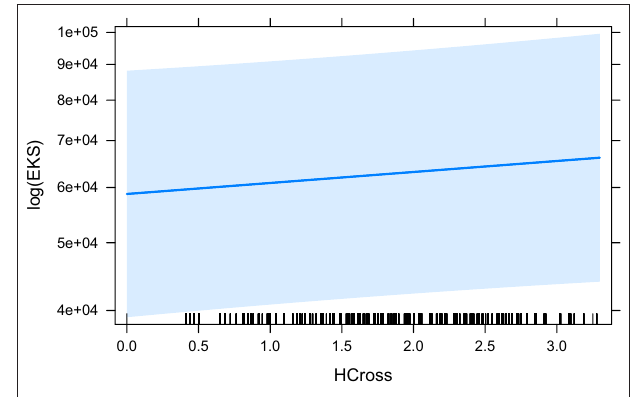
FIGURE 3 | The effect of HCross on the logarithm of FFDur.